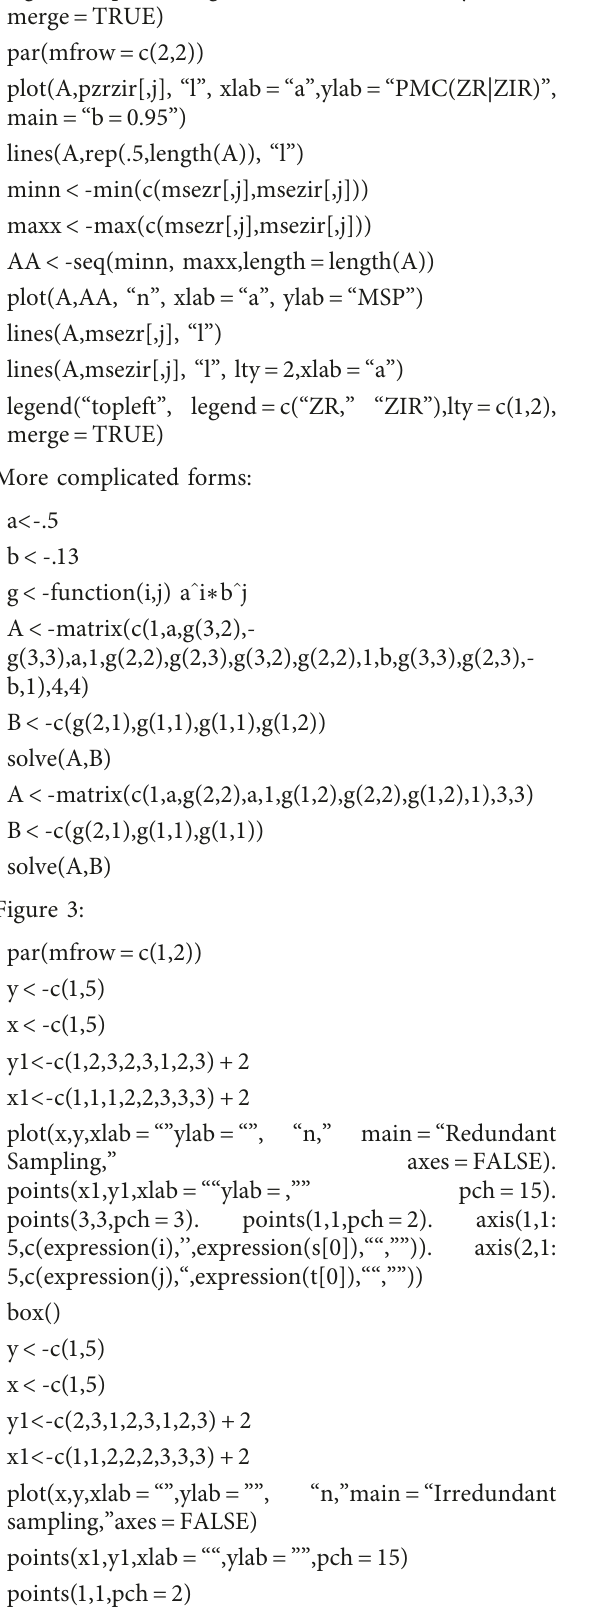
points(x1,y1,xlab � ““ylab � ,””